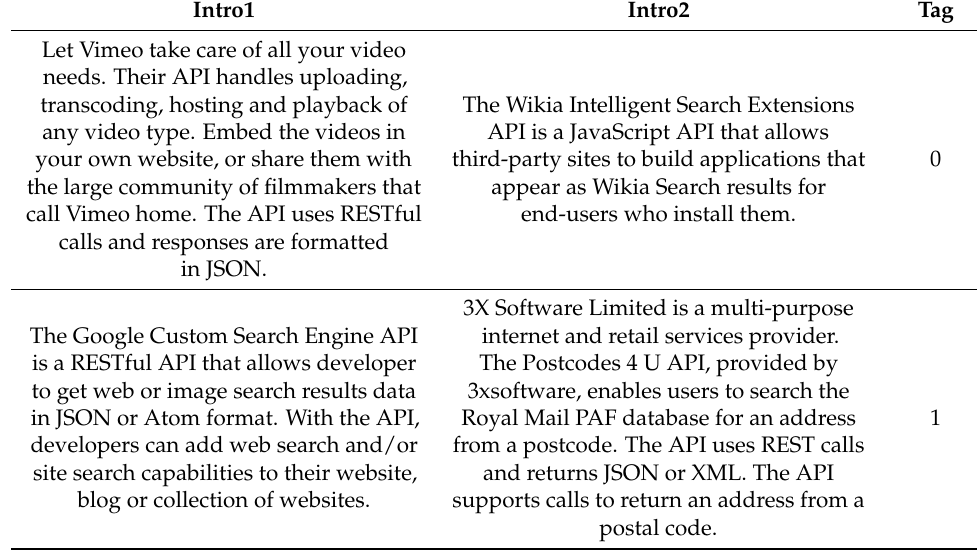
Table 1. Sample data in the Semantic Relationship Detection